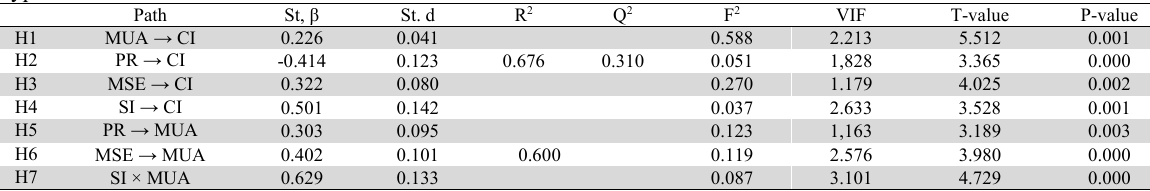
Hypothesized Direct Effects in the Structural Model